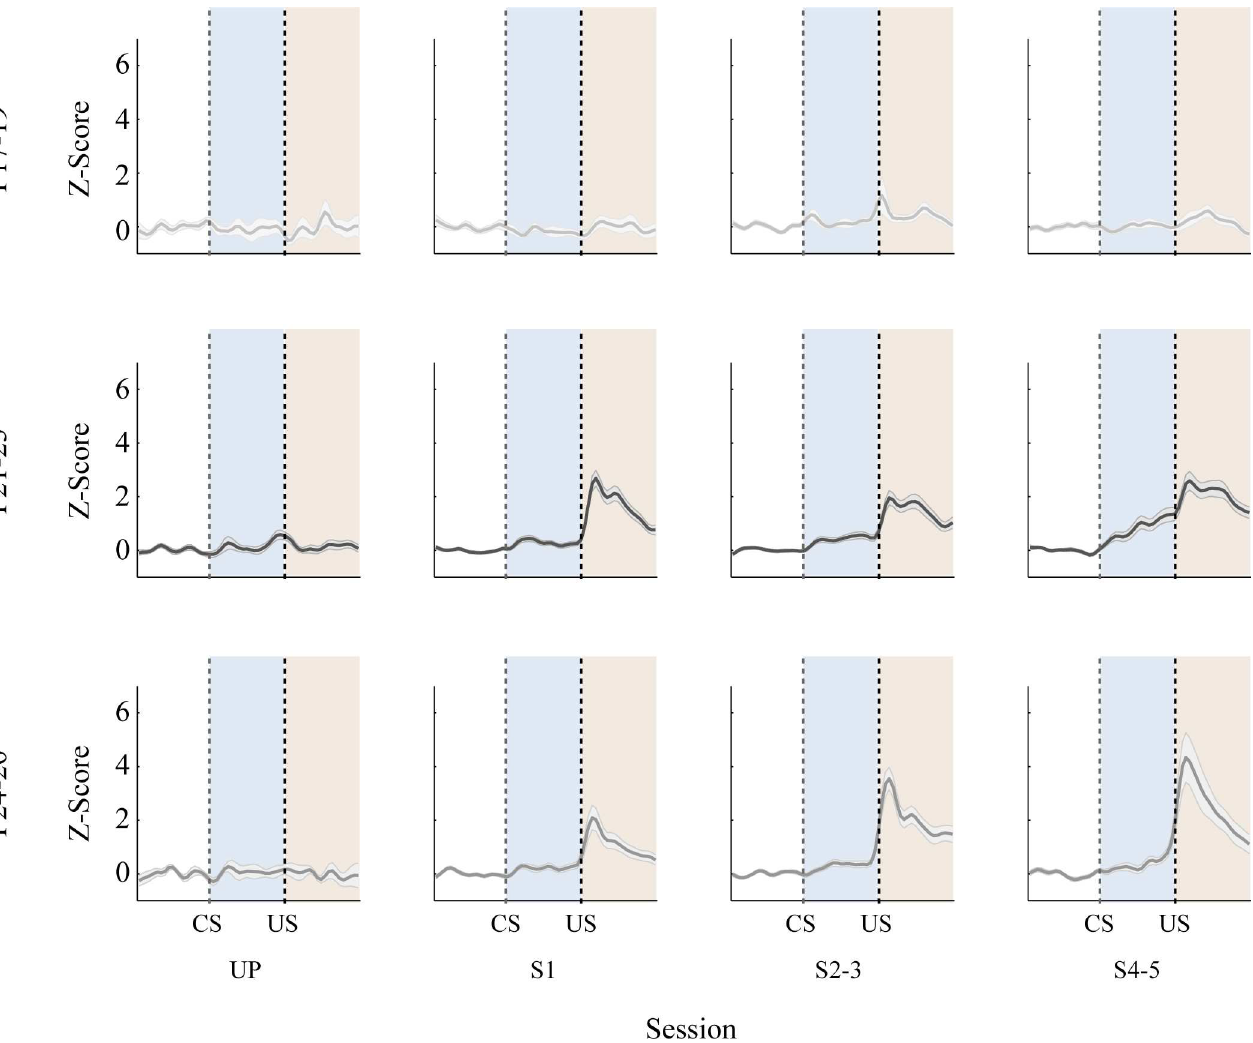
Fig 7. Mean (+/- SE) CA1 pyramidal cell firing rate changes in rat pups given delay eyeblink conditioning on postnatal days (P) 17–19, P21-23, or P24-26. During the unpaired(UP) session, firing rates were comparable during the stimuli across age groups. Once paired sessions (S1, S2-3, and S4-5) started, however, neuronsin the older age groups showed greater activity during both the CS and post-US periods. The differences between the P17-19 group and the older groups became larger with the training, especiallyin the post-US period. Firing rates between the P21-23 and P24-26 groups were